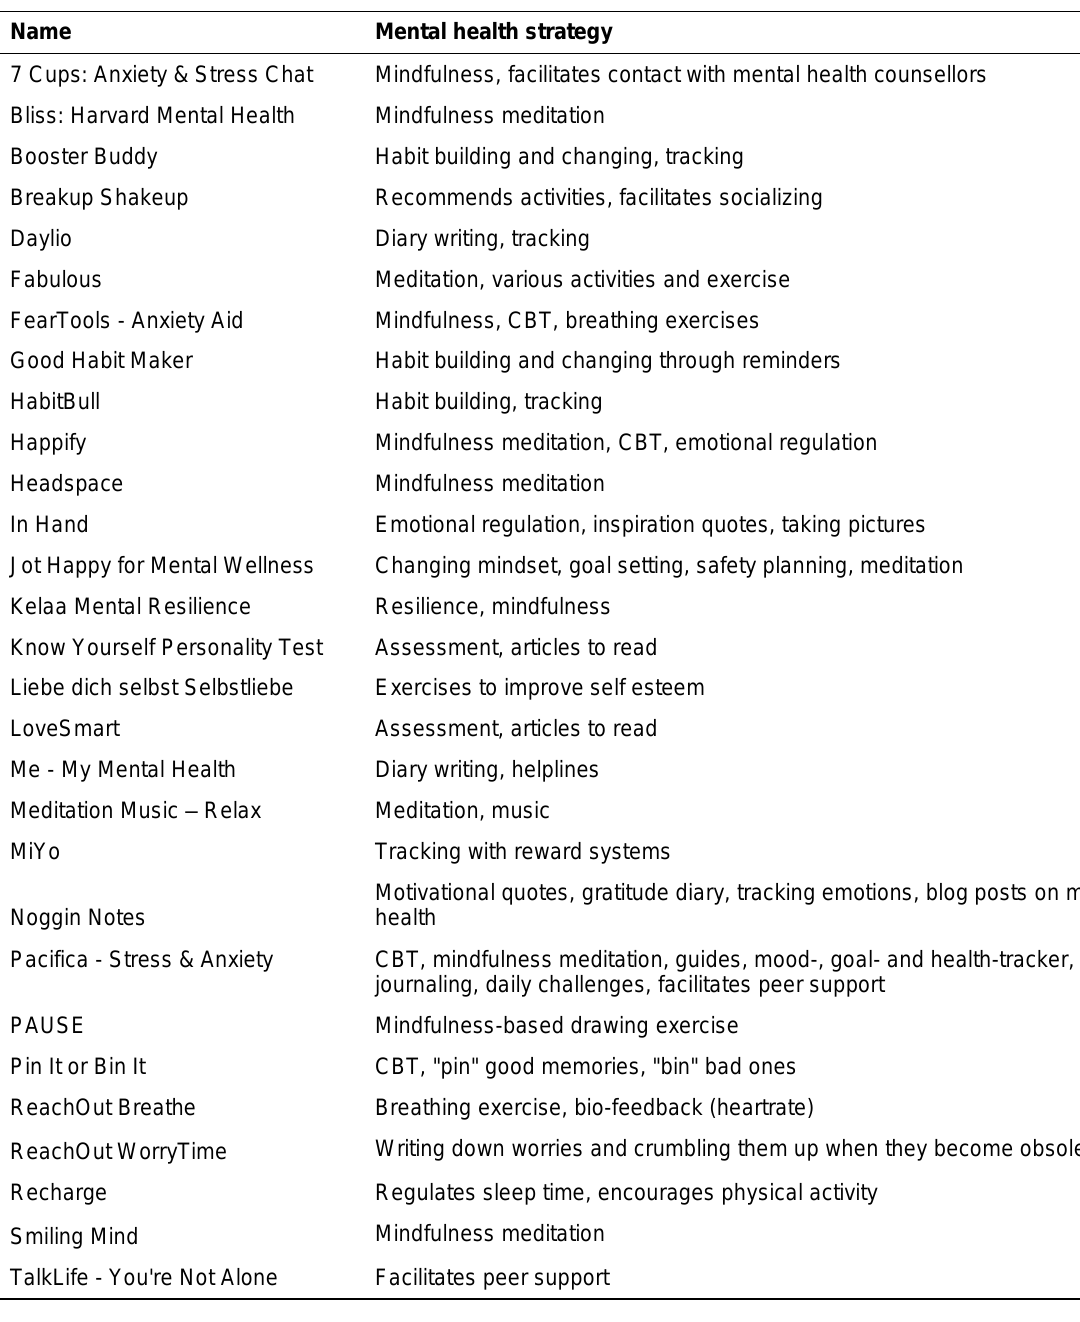
Table 3. Included apps and mental health